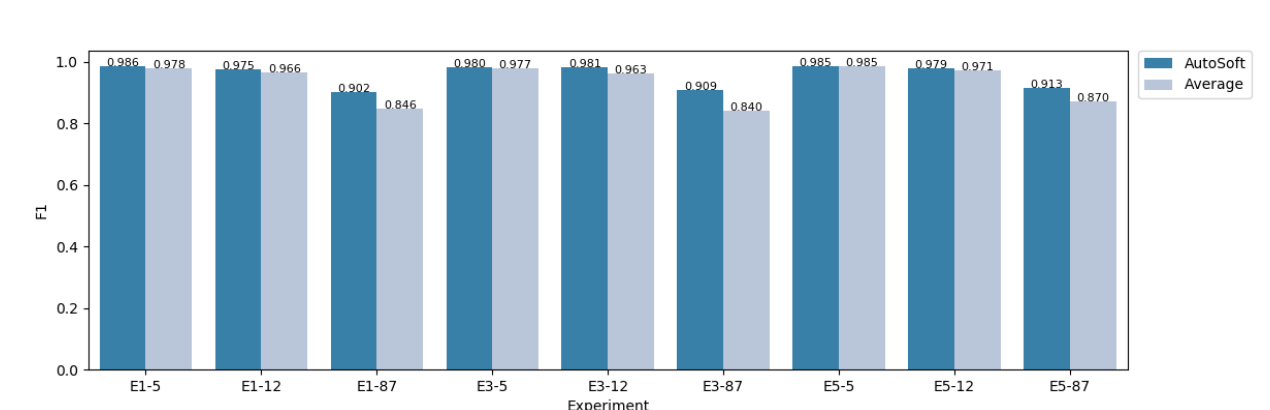
Figure 6. F 1 -scores obtained for AutoSoft and the average F 1 -scores obtained for the other classifiers in experiments E X - Y shown in Table 3, where X = N -gram size and Y = number of